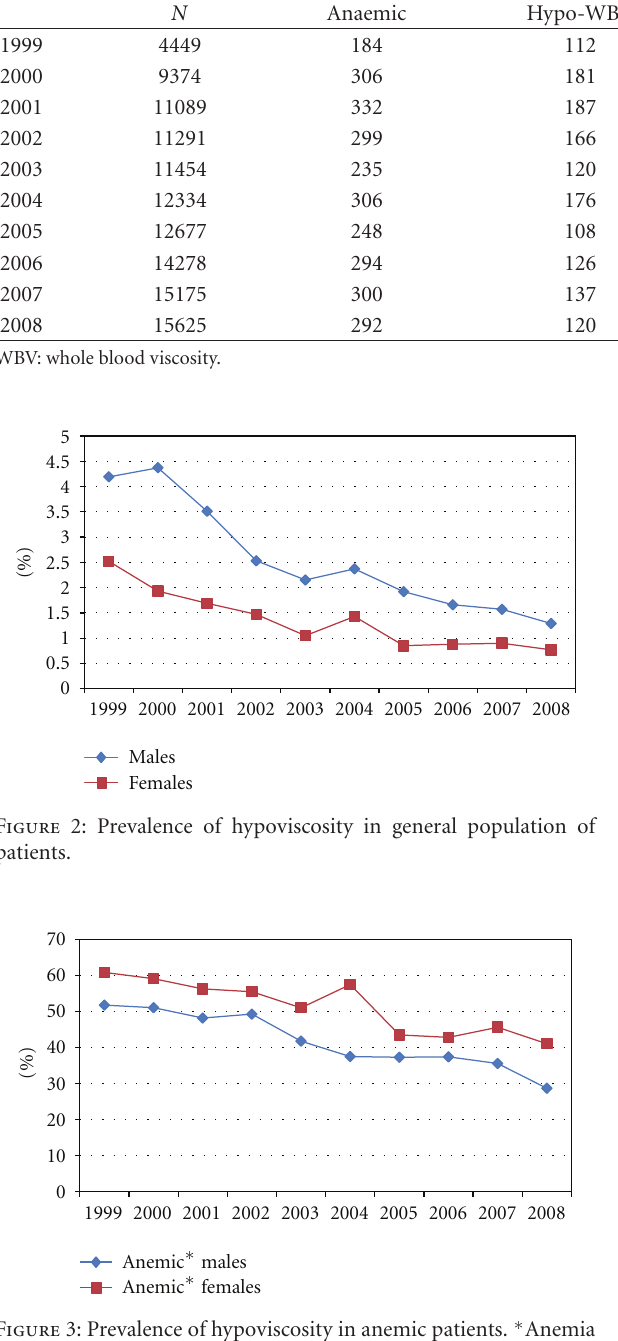
Table 2: Numbers of anaemia with confounding hypoviscosity among females and males. Females